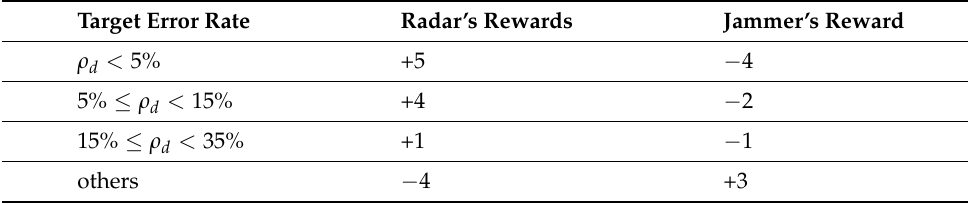
Table 5. The reward value of the radar side and the